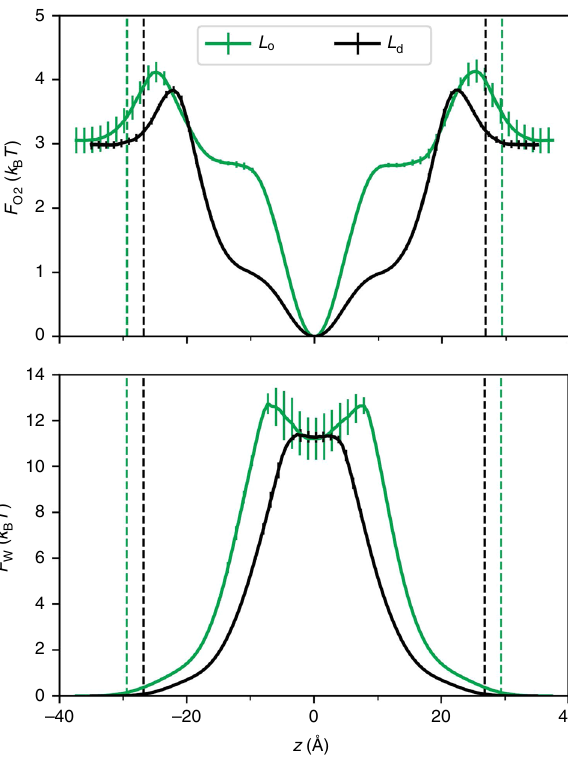
Fig. 2 Free energy pro fi les for oxygen and water. The pro fi les F ( z ) were computed from the histogram p ( z ) for oxygen (top) and water (bottom) as a function of position with respect to the membrane center at z = 0. Error bars show the standard deviation over the four replicates. The pro fi les were not symmetrized, showing the good convergence of the data. The dividing surfaces at z = ± h /2 used in the analyses are denoted with vertical dotted lines. Source data are provided as a Source Data fi le.